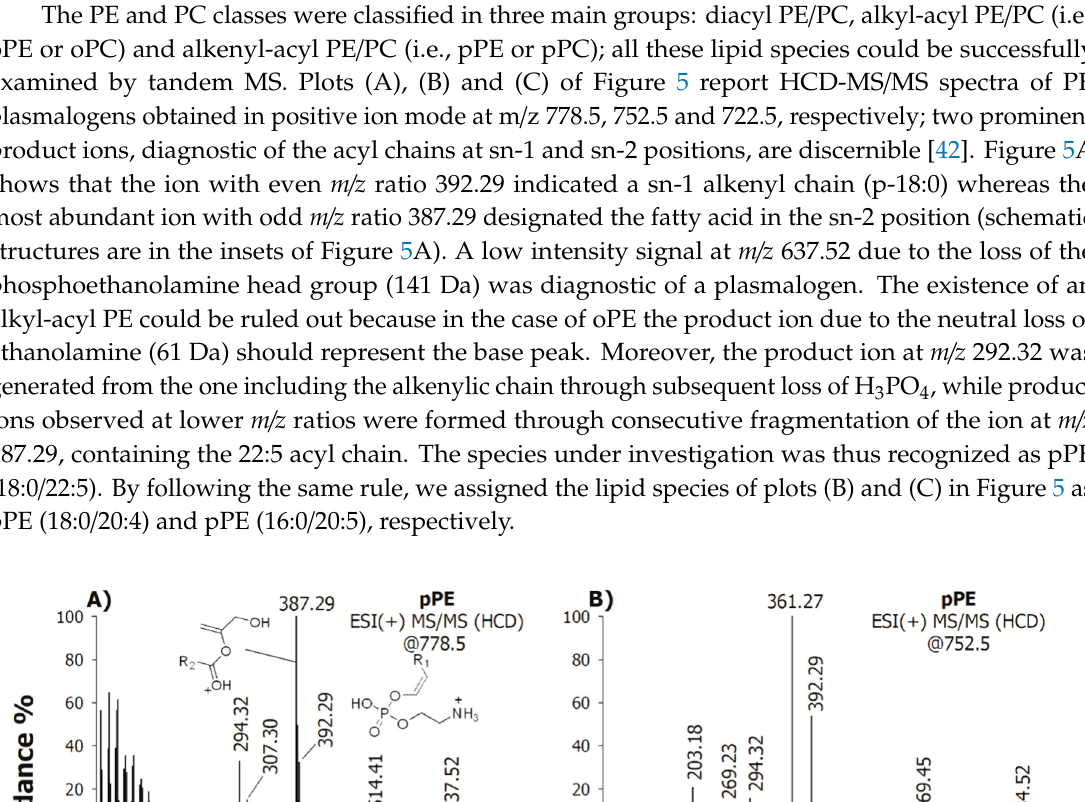
assignment. Figure 4D is the CID tandem MS spectrum in negative ion mode of a SM (36:2;2) as [M −